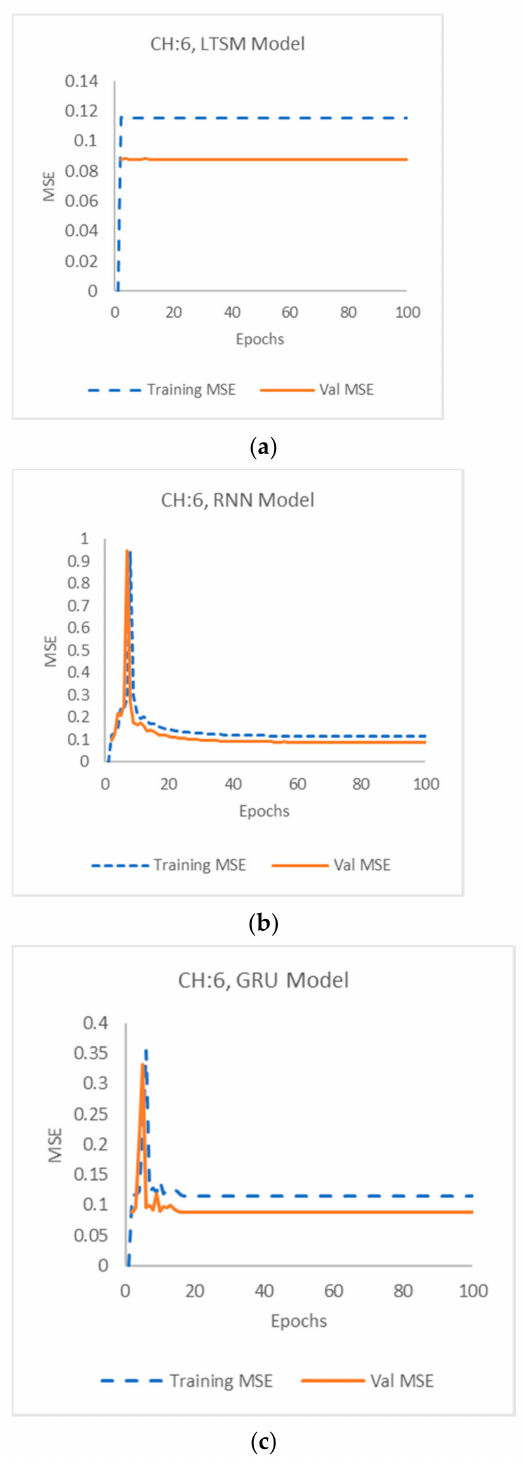
Figure 28. Channel 6: Training and validation error using ( a ) LSTM, ( b ) RNN and ( c ) GRU